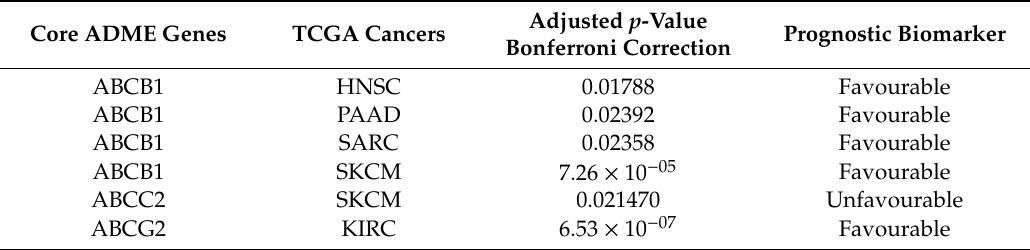
Table 2. Kaplan-Meier survival analyses / logrank tests showed associations of intratumoral expression levels of core ADME genes with favourable or unfavourable overall survival rates in TCGA cancer